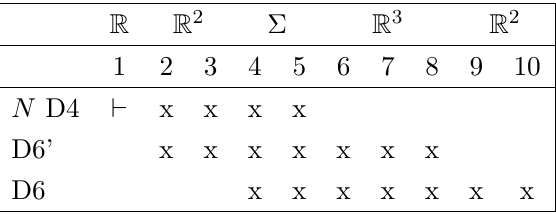
Table 5. Type IIA setup in the pole region after reduction on the circle of